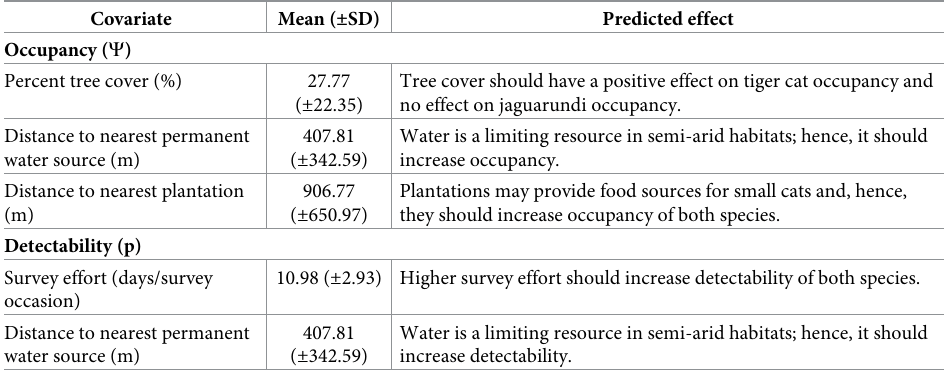
Table 1. Summary of covariates and their predicted effects on northern tiger cat and jaguarundi occupancy and detection probabilities at the Tamandua´ Ranch.